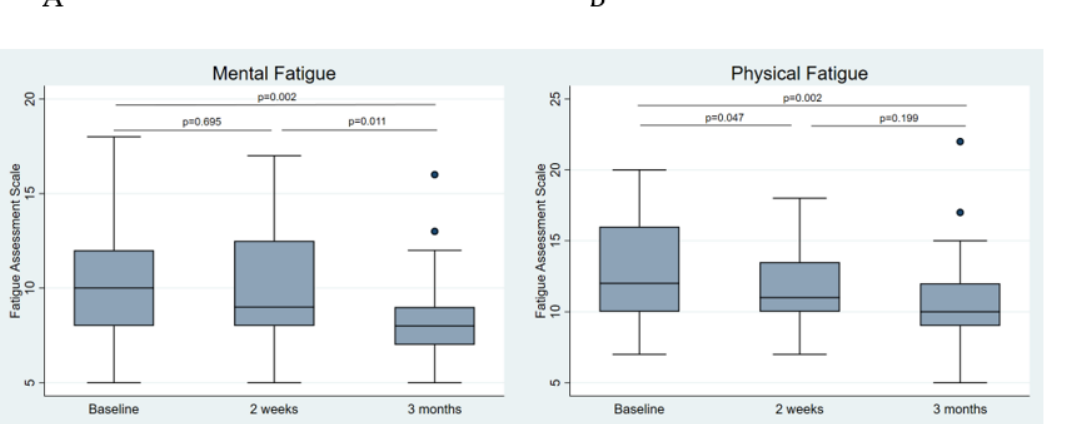
Figure 5. Changes in subclassifications of fatigue through intermittent fasting assessed by the Fa- tigue Assessment Scale (FAS). ( A ) Mental fatigue changes. ( B ) Physical fatigue